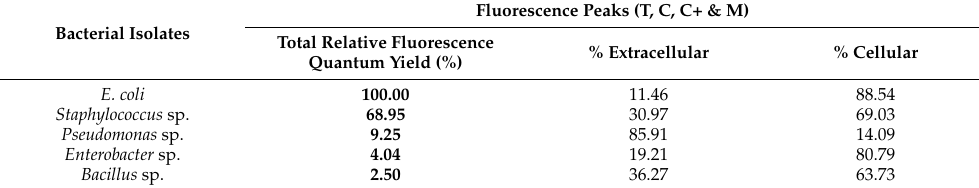
Table 2. Total relative fluorescence quantum yield for five environmental bacterial isolates (isolated from an environmental freshwater sample) after growth for 24 h at 30 ◦ C; total fluorescence quantum yield is determined from the summative fluorescence intensities (normalised to cell densities) for peaks T, C, C+ and M, normalised to the highest intensity. The percentage of the total calculated fluorescence which is attributed to extracellular material (supernatant fraction) and cellular material (resuspended and lysed cells) is also shown. Fluorescence Peaks (T, C, C+ & M) Bacterial Isolates Total Relative Fluorescence Quantum Yield (%)